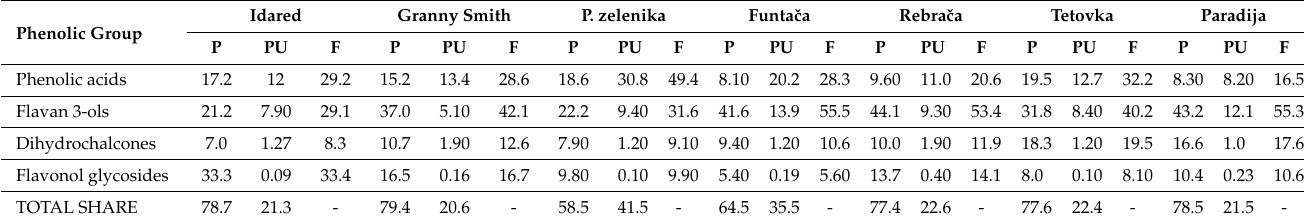
Table 2. Average share of phenolic groups in peel, pulp and whole fruit